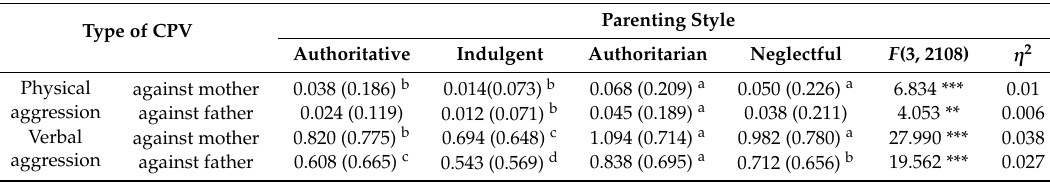
Table 3. Means, standard deviations, and di ff erences between parenting styles and dimensions of child-to-parent violence